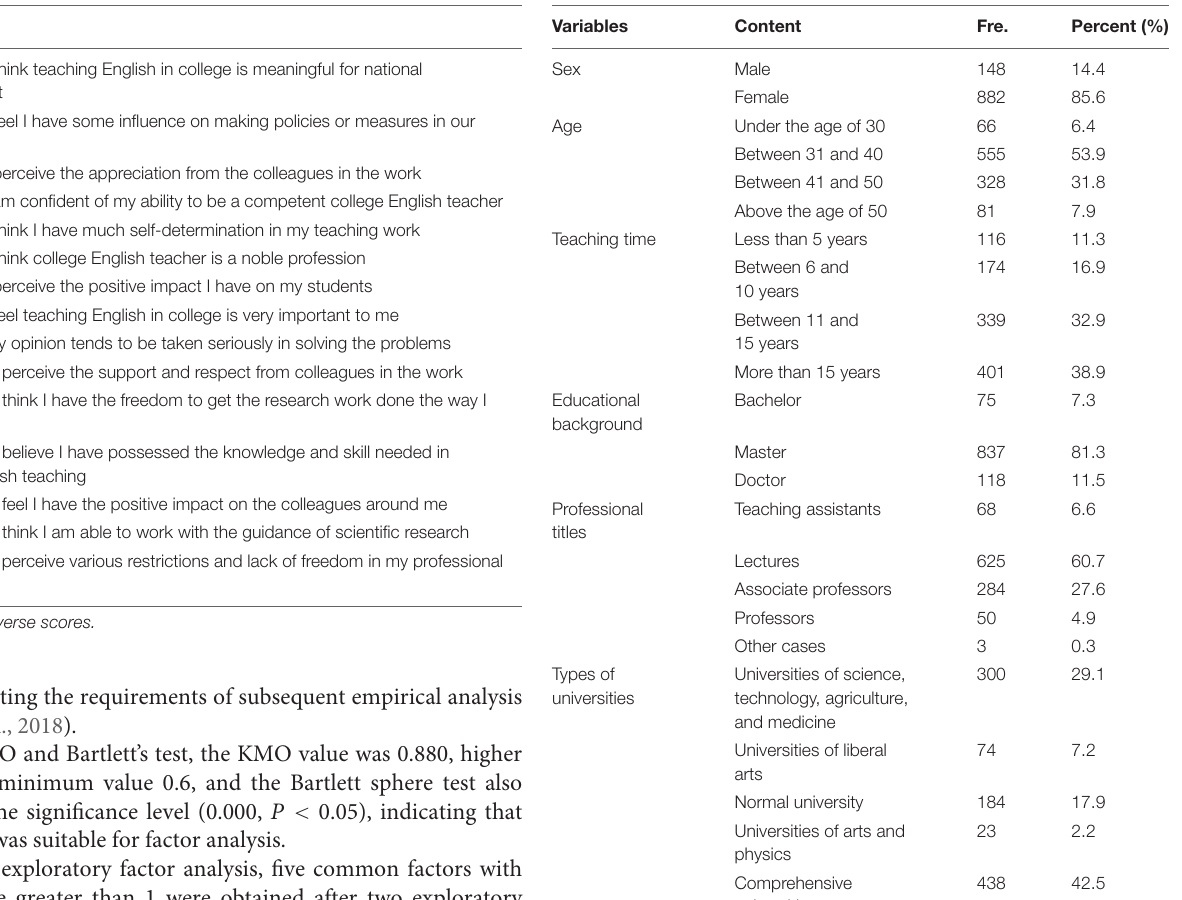
TABLE 8 | Background information of the teachers participants ( n = 1030).